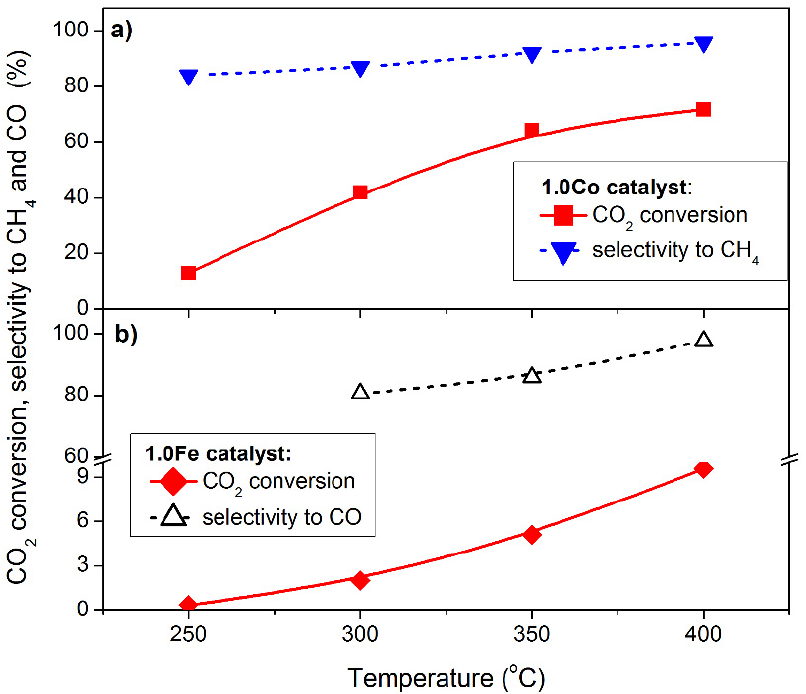
Figure 7. Catalytic performance of the “pure” cobalt-based and the “pure” iron-based thin films in CO 2 hydrogenation in terms of CO 2 conversion and dominating selectivity. Reaction conditions: H 2 /CO 2 = 4/1; 25 sccm, amount of catalyst 0.7 g (38 cm 2 ). ( a ) 1.0Co catalyst; ( b ) 1.0Fe catalysts.